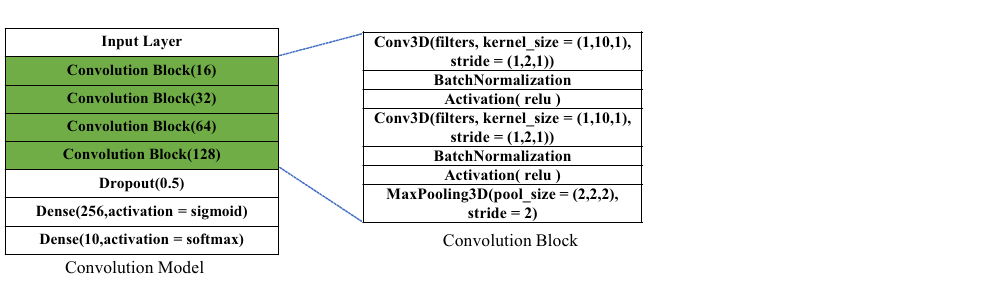
Figure 8. 3D Sequential Branch in the proposed